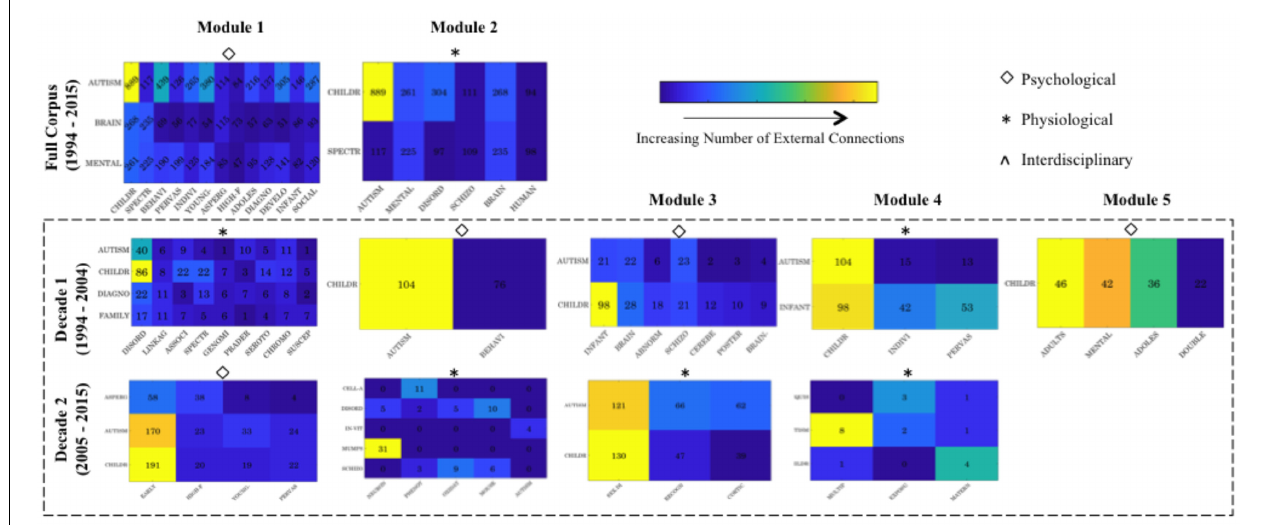
FIGURE 4 | Summary matrices visualizing the external connections between modules identified across each level of the corpus. Prominent internal module keywords are indicated on the x-axis, while primary external module partner keywords are represented on the y-axis. Note external partner keyword (y-axis) can appear more than once across multiple external connections for individual modules. For instance, the term Brain acts as a prominent external connection for more than one module, and thus is a core network hub enabling multiple module connections. Matrix colors are indicative of normalized levels of external connectivity, with lighter colors denoting a larger number of normalized connections (original count data is also indicated). The top panel provides an overview of the Full Corpus modularity analytics demonstrating cross talk between the psychologically themed M1 and physiologically themed M2. The two lower panels illustrate Decade 1 and Decade 2 modularity analytics respectively, demonstrating external connections between core modules. While Decade 1’s self-identified modules appear to display nuanced levels of integration in M1 and M3, closer inspection demonstrates these are limited to arguably higher-level external descriptor terminology such as ‘Autism’ and ‘Children.’ Further, Decade 2 M2 and M4 display a range of external junctures, yet these appear to be largely intra-thematic. For yearly (1994, 2006, 2015) assessment see Supplementary Figure 4 . For larger high resolution figures please see